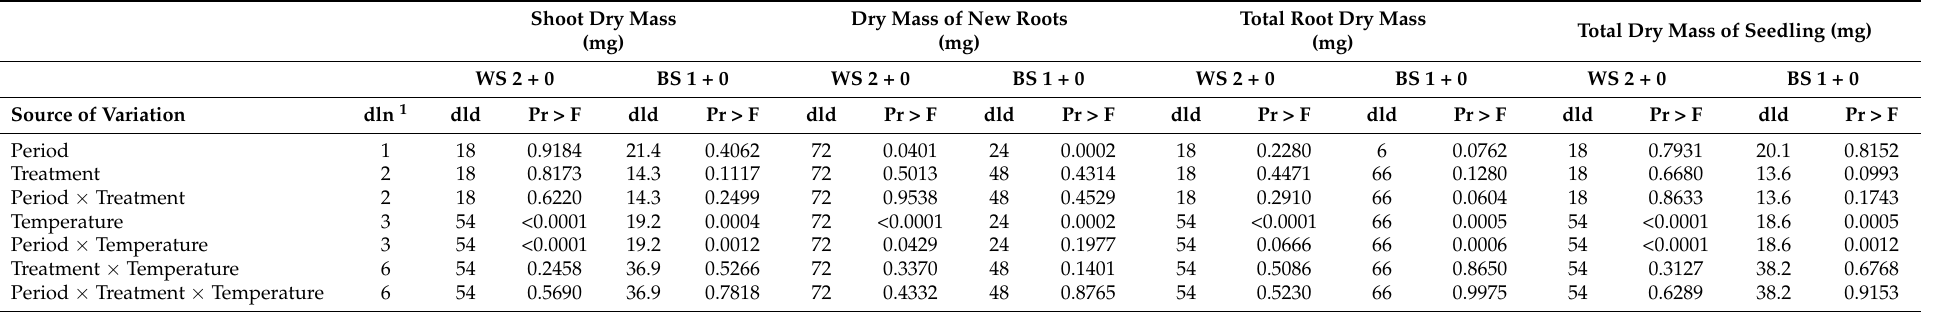
Table 6. Observed probabilities (Pr > F) and degrees of freedom of the fixed effects associated with the analysis of variance of different growth variables of two-year-old white spruce (WS, 2 + 0) and one-year-old black spruce (BS, 1 + 0) seedlings at the beginning (mid-January) and end of winter